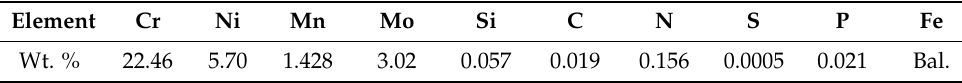
Table 2. Chemical composition of the base material (BM).